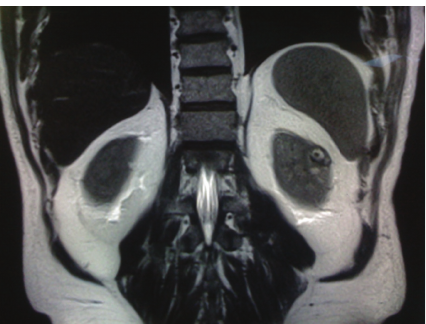
Figure 1: Coronal MR image of a 51-year-old male patient who has presented due to an incidentally diagnosed left renal mass. Tumor was measuring 2cm in its greatest dimension and R.E.N.A.L. score was 8. He was managed by off-clamp RANSS. Eventual histopathologic diagnosis was Fuhrman grade 3, pT1a, and papillary RCC.